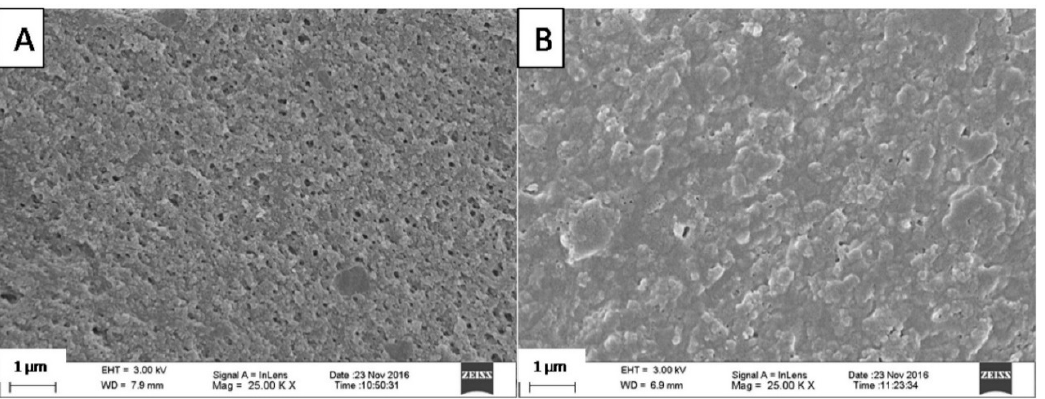
Figure 3. Pore formation during acid treatment of the films: GA2 without carrageenan ( A ) and GA3containing 1.5% carrageenan ( B ). Scale bar—1 μ m.